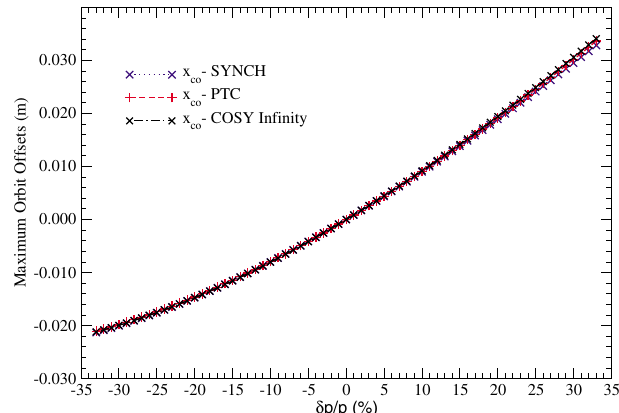
FIG. 4. (Color) Comparison of the maximum orbit offset calcu- lated by the three codes: PTC , COSY INFINITY , and SYNCH , over the muon acceleration range from 10 and 20 GeV.